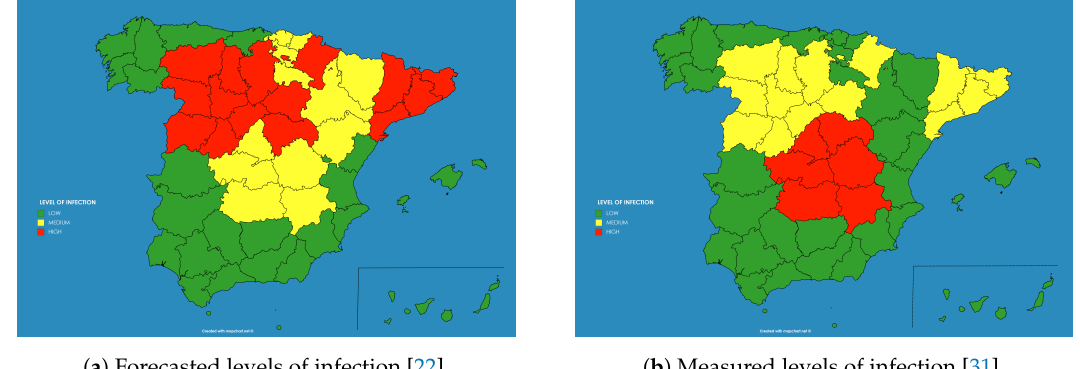
Figure 10. Levels of infection in the population at each region of Spain: calculated in April 2020 by using the model presented in this paper ( a ) and measured at the seroprevalence study ENE-COVID finished in July 2020 ( b